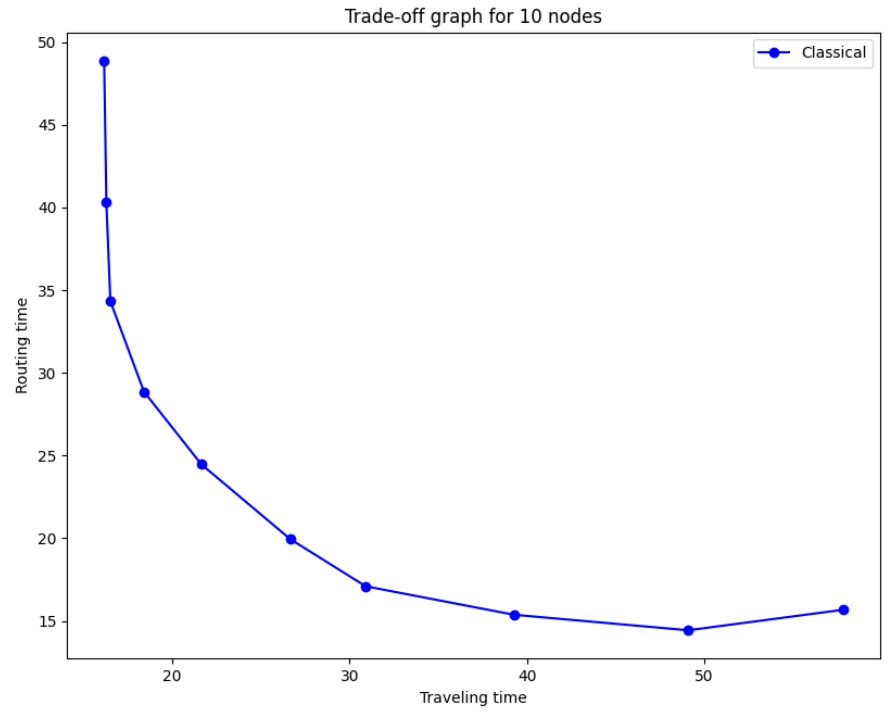
Figure 4. Trade-off between traveling and routing time for different p values between 0 and 0.9. Values of p closer to 0 give a high traveling time and low routing time. Values of p closer to 1 give a low traveling time and high routing time.